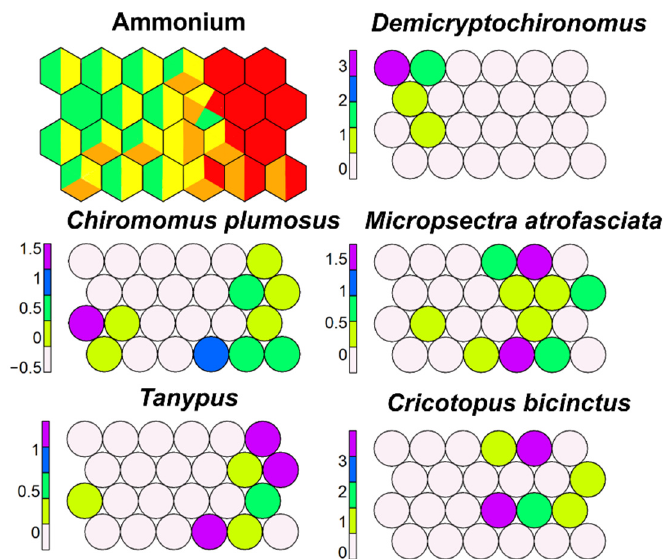
Figure 18. Supervised map of sites and five morphotaxa clustered using NH 4 (in µg L − 1 ) as external variable. Green, 1–20 µg L − 1 ; yellow, 20–100 µg L − 1 ; orange, 100–250 µg L − 1 ; red, >250 µg L − 1 .